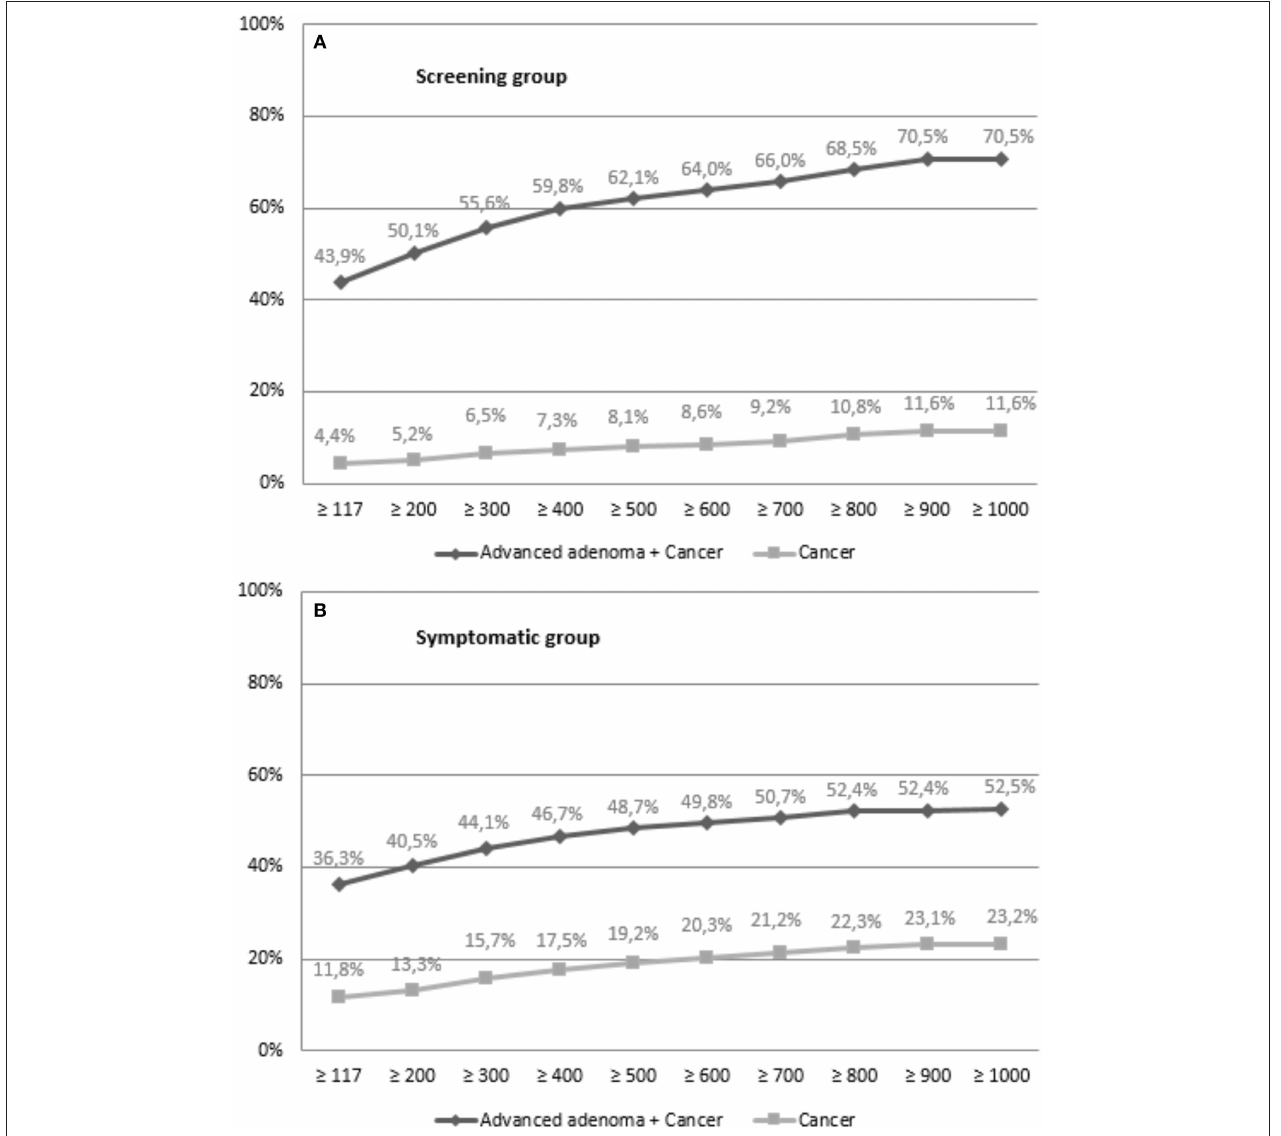
FIGURE 2 | PPV according to fecal hemoglobin concentration in (A) screening group and in (B) symptomatic